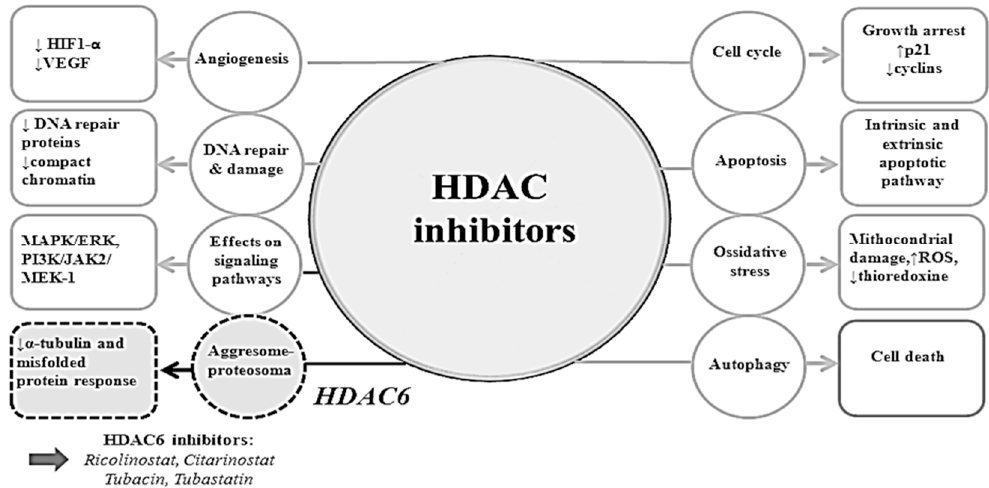
Figure 2. Effects of HDAC inhibitors on tumor cell. Exposure to HDAC inhibitors leads to a wide spectrum of biologic effects, including induction of apoptosis, inhibition of angiogenesis, ossidative stress, effects on signaling pathways, and disruption of the aggresome related to HDAC6 (increases ↑ ; decreases ↓ ) .